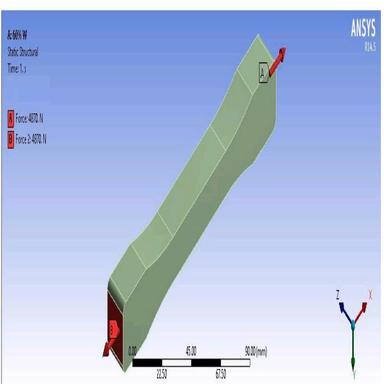
uniaxial tensile load is applied on both ends.